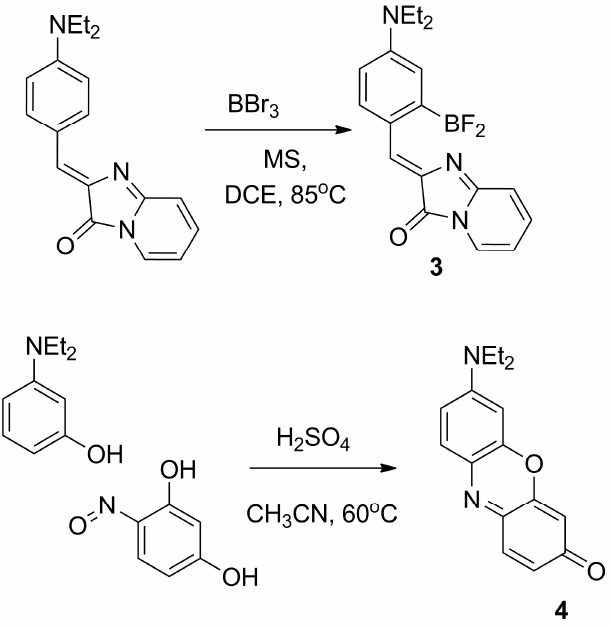
Scheme 3. Synthesis of compounds 3 and 4 : locked analogs of compound M739 .